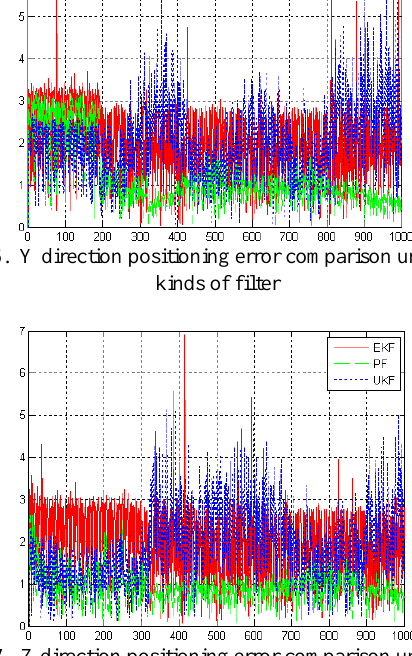
Figure7. Z direction positioning error comparison under three kinds of filter